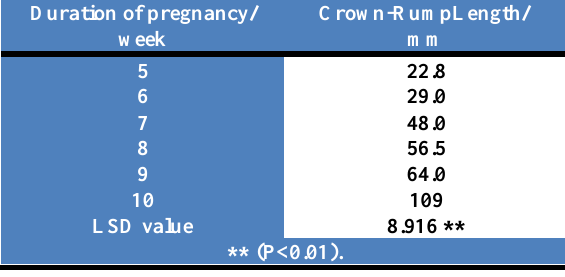
Table, 1: Relationship between gestation age and CRL.